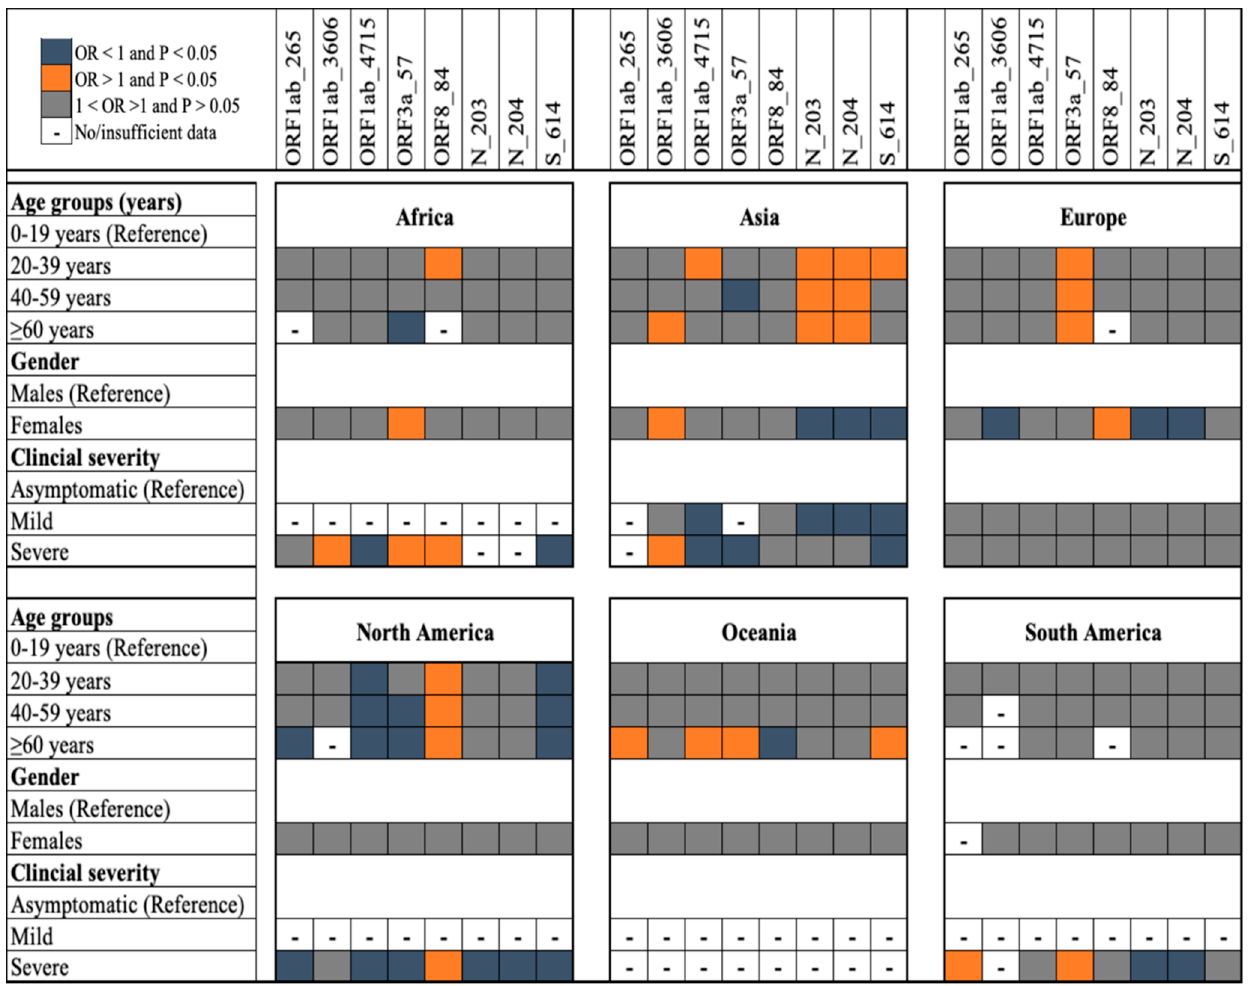
Figure 2. Epidemiology of infection with variant-specific alleles at eight informative loci in SARS-CoV-2 genomes sampled in 2020. The likelihood of patients harbouring an infection that carried a mutant allele at the eight informative loci was compared among patients in different age groups, gender, and geographical regions and patients with different COVID-19 forms. The adjusted odds ratio (OR) with the p -value is depicted with orange, blue, and grey colours corresponding to OR > 1 and p -value < 0.05; OR < 1 and p -value < 0.05; and 1< OR > 1 and p -value > 0.05, respectively. – indicates no data, i.e., the OR was not estimated due to the sample size being less than five. 5. Population Genetics of SARS-CoV-2 Infections in 2020 We constructed a multilocus genotype (MLG) for each of the 22,164 genomes in- cluded in this study to evaluate the utility of the 74 polymorphic loci as a genetic tool for differentiating SARS-CoV-2 variants and for monitoring their evolution in different geo- graphical regions. Among the 5959 genomes in the 2020 study population, 472 unique MLGs were detected in the global population, with MLG repertoire sizes ranging from 40 for South America to 185 for Asia (Table S5). The mean E.5 score of 0.34 for the global repertoire indicated the presence of predominant MLGs (Table 2). As an example, in each continent, at least the first six most prevalent MLGs were shared by more than 50% of the genomes sampled (Table S5), suggesting that the majority of clinical cases in 2020 were caused by variants with these and/or closely related MLG signatures.